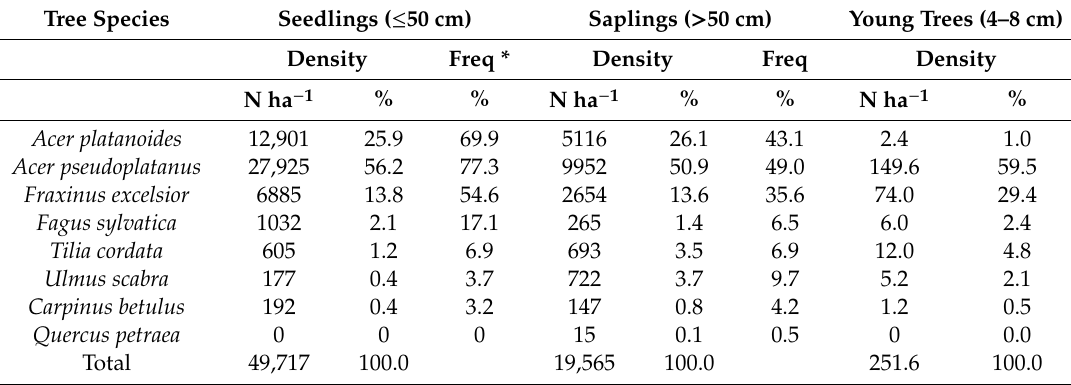
Table 3. Density of natural regeneration on the permanent research plot